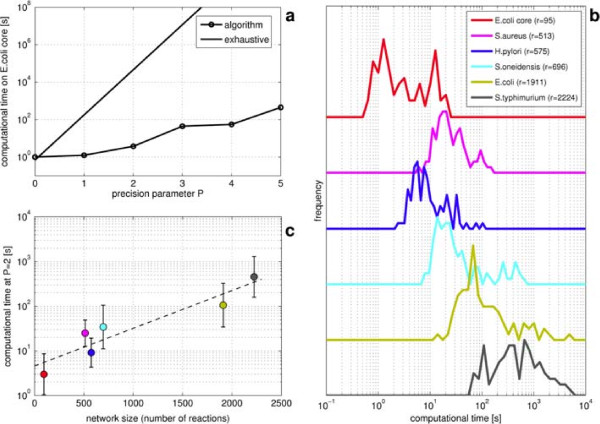
Algorithm performances. (a) Computational time of the algorithm compared with an estimation of the exhaustive search for different values of P on the E.coli core metabolism. (b) The influence of the size of the network on the performances is here reported as distribution of the computational time for the 6 metabolic networks listed in Table
2. Each distribution is built over 100 random samples obtained by changing the targets of a fixed number of drugs and keeping the precision parameter and the threshold constant (P = 2 and τ = 0.35). (c): Averaged computational time (same color code of the corresponding distributions reported in panel (b)) and error bar as a function of the size of the network (expressed as number of reactions, see Table
2). All tests have been carried out using the software ILOG-IBM CPLEX on a 2.3 GHz CPU.